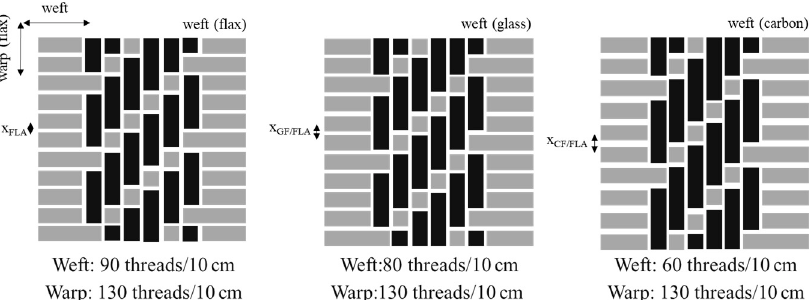
Table 2. Yarn types used for the manufacture of the hybrid textiles.